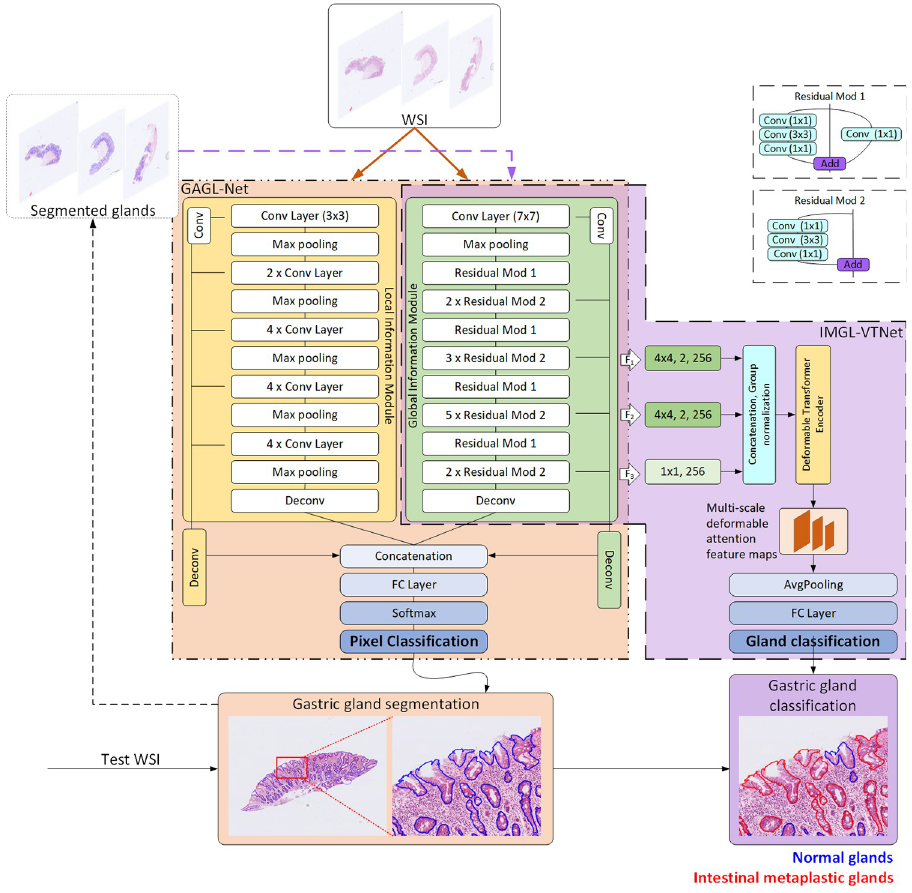
Fig 2. The proposed GAGL-VTNet model for gastric gland segmentation and classification. mainly due to the inter-observer variability. Thus, in the proposed workflow, which aims to address the aforementioned challenge, we extract different receptive field features and multi- level contextual features through a two-branch model. More specifically the segmentation part (Fig 2: GAGL-Net) of the proposed GAGL-VTNet model comprises a local module inspired by the DCAN [22] and a global module inspired by the ResNet-50 [23]. The parallel use of two modules enables the exploitation of both multi-scale local and abundant global information. In the global module the input image patches with size of 480 × 480 × 3 pass through a 7 × 7 con- ventional convolution layer while in the local module they pass through a 3 × 3 convolution layer. Each module includes a downsampling path and an upsampling path extracting different receptive field features. Thus, further exploitation of contextual information and finer details is incorporated. More precisely, a set of low-level features from the bottom layers is extracted that contributes to the multi-size gland segmentation. In addition, the utilized higher level fea- tures increase the overall detection accuracy of degenerated and elongated glands. In order to extract higher-level semantic information preserving the resolution, the stride and dilation of the last stage of the global module are set equal to 1 and 2 respectively. Then, the correspond- ing feature maps are upsampled combining convolutional and deconvolutional layers and they are concatenated to achieve pixel-level semantic segmentation. In the proposed model, the convolutional layers are followed by the batch normalization and ReLU activated function.